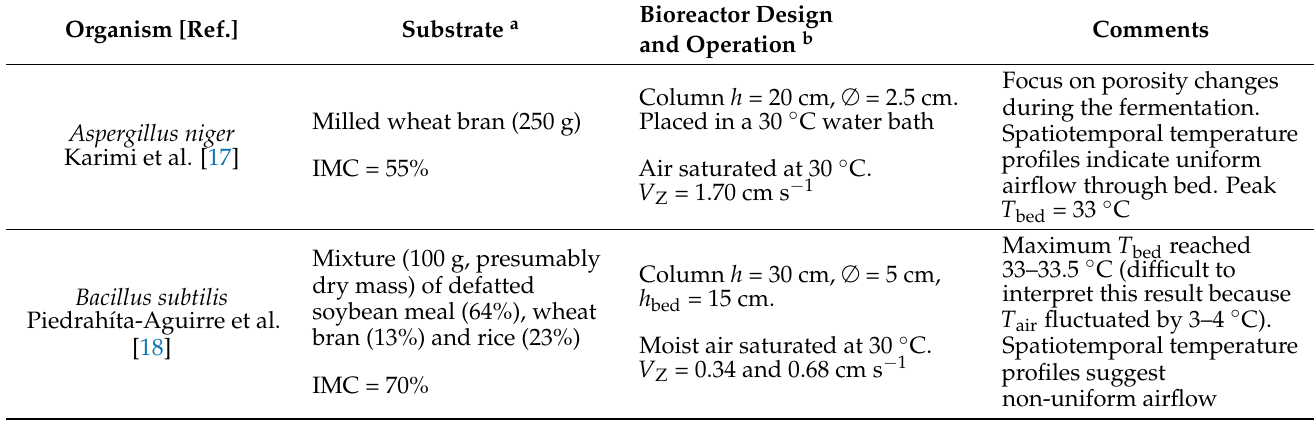
Table 2. Studies in which axial temperature gradients give insights into the uniformity of airflow. Organism